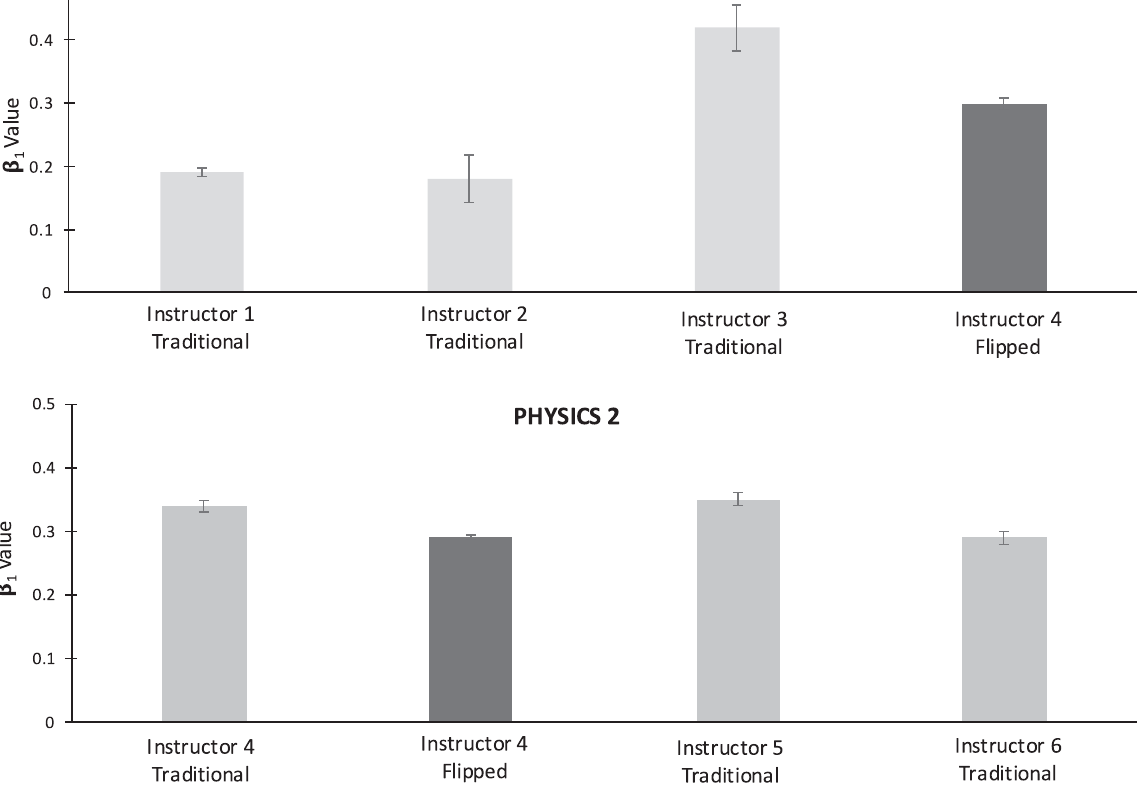
FIG. 4. Gender standardized coefficients ( β 1 values) for different instructors and class types in physics 1 (top row) and physics 2 (bottom row) courses. Darker and lighter bars represent flipped and traditional physics courses, respectively. Error bars represent standard error of the β 1